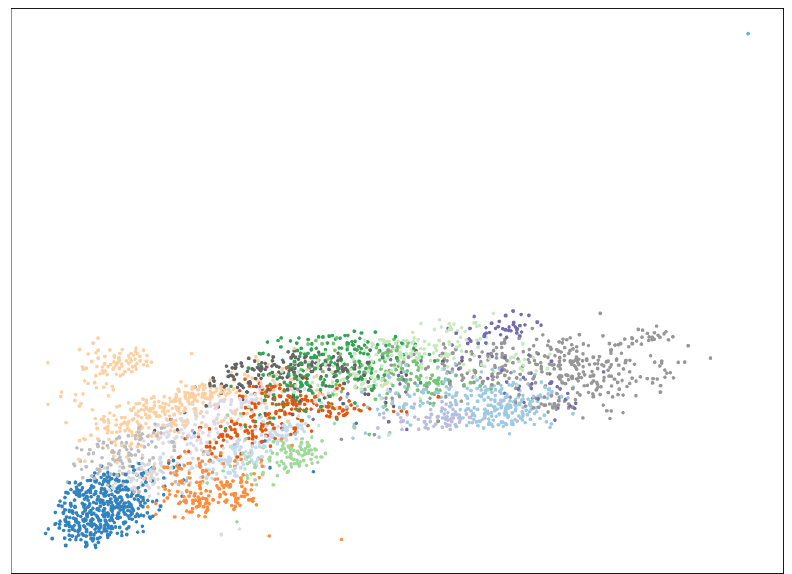
Figure 7. Example research fronts